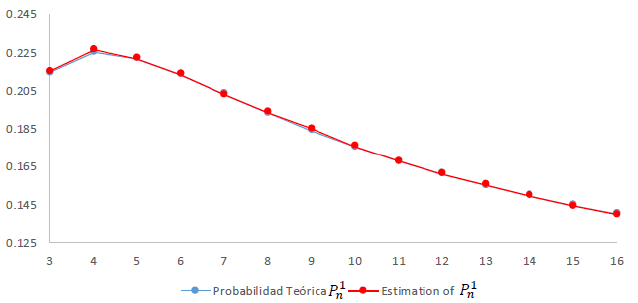
Figure 8. For n = 3, . . . ,16: Graph of the Theoretical probabilities P 1 n (in blue) and comparison with their estimate (cid:100) ( P 1 n ) (in red) using a swap in M = 1,000,000 of different initial